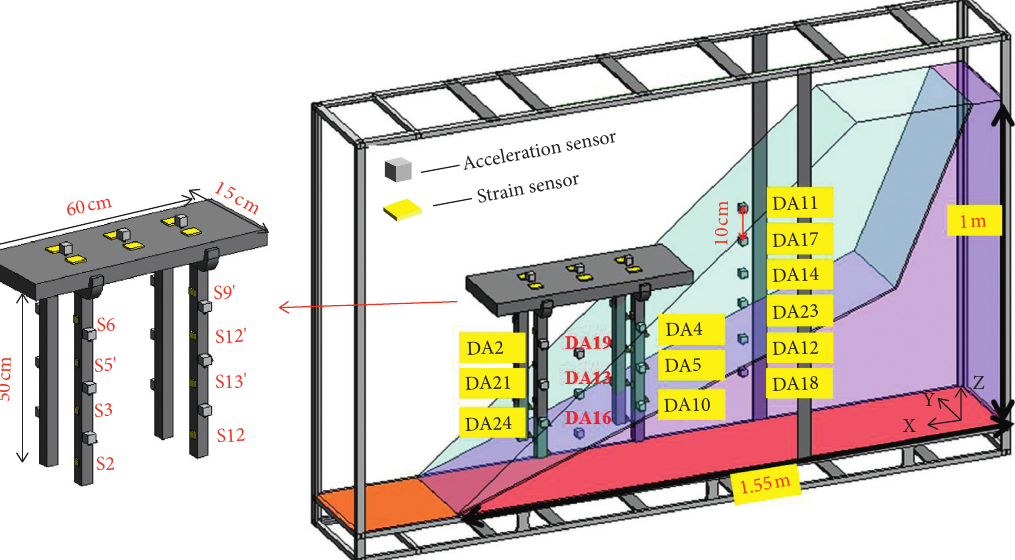
Figure 4: Sensor